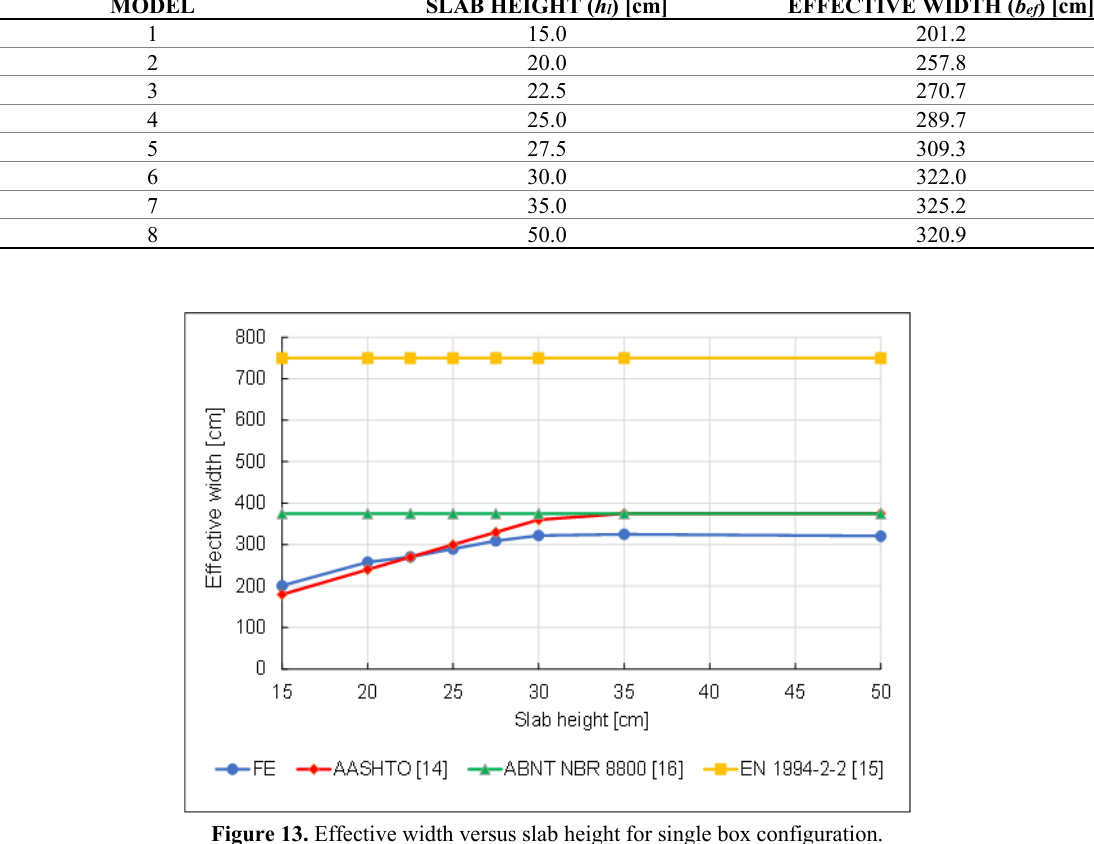
Figure 13. Effective width versus slab height for single box configuration.